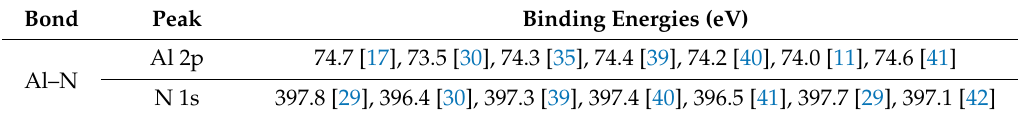
( b ) Figure 10. Comparison of high-resolution O 1s spectra of: ( a ) as-deposited AlN sample; ( b ) annealed AlN sample. 3.3. Secondary-Ion Mass Spectrometry To further investigate the chemical composition as well as to provide depth profiling of the films obtained, the secondary-ion mass spectrometry (SIMS) was utilized in time-of-flight mode. The main principle of this mode is that different ions require different periods of time to reach the analyzer due to mass discrepancy; this period of time is then counted and used to detect and identify an ion using the software with an extensive built-in database. The SIMS equipment used in this work utilizes two ion-guns, one of which is used for sputtering only and the other with much lower energy is used for analysis. For sputtering, we used oxygen ions with energy of 2 keV for creating a crater and bismuth ions for analyzing the sputtered area along the way. Every 2 s of sputtering was followed by 3 s of analysis. The area of the crater was 200 nm × 200 nm; the area of analysis was 50 nm × 50 nm. The depth profiling spectra for O − , AlO − , Si − , Al − , AlN − and SiO − for both annealed and unannealed samples are given in Figure 11a,b.